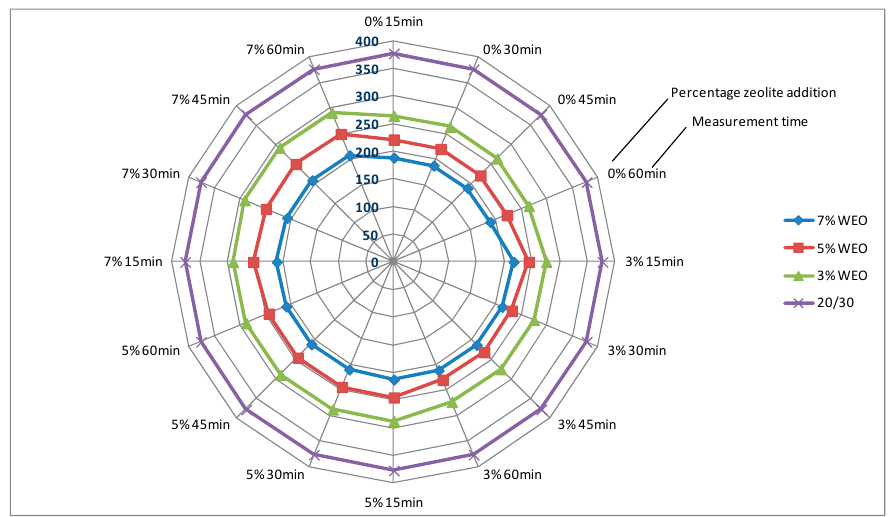
Figure 4. The results of dynamic viscosity tests for the 20/30 asphalt with the addition of WEO and the Na-P1 zeolite measured at 160 °C (mPa·s).